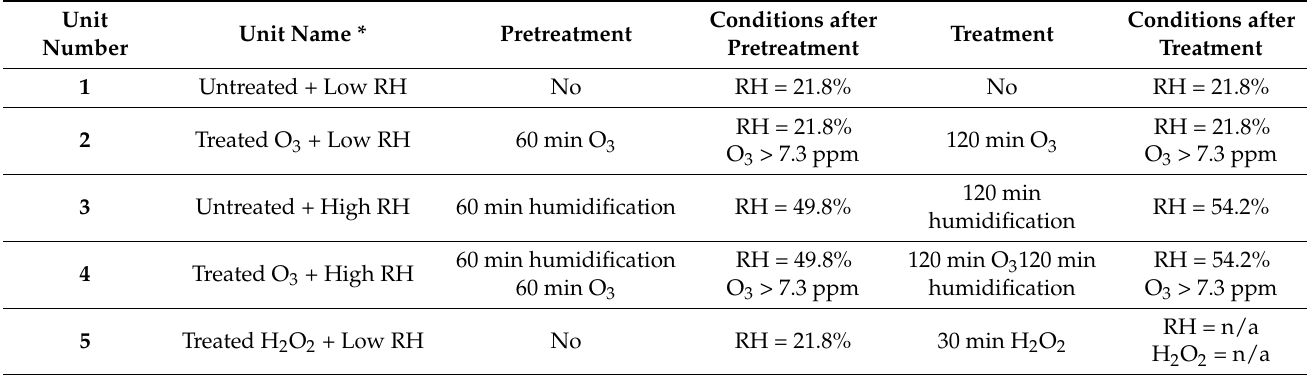
Table 1. Units in the study. Description of the environmental conditions applied in respective study units. Pretreatment was applied for 60 min and followed by 120 min (ozone) or 30 min (hydrogen peroxide) of treatment.